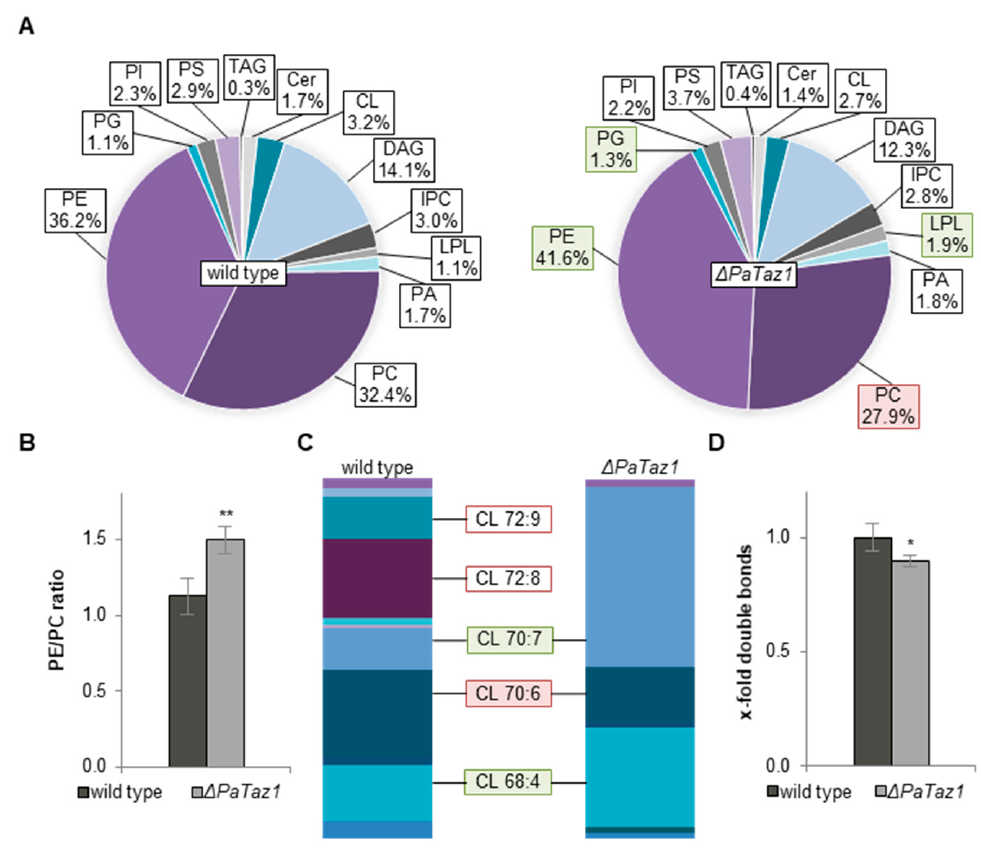
Figure 4. Loss of PaTAZ1 has a dramatic impact on phospholipid metabolism. ( A ) Lipid profiles of mitochondrial protein extracts of P. anserina wild type ( n = 5) and ∆ PaTaz1 ( n = 3). Significant differences to the wild type are marked with green (increase) or red (decrease) boxes, respectively. Exact values are shown in Supplementary Materials (Table S1). TAG: triacylglycerol; Cer: ceramide; CL: cardiolipin; DAG: diacylglycerol; IPC: inositol phosphorylceramide; LPL: lyso-phospholipids; PA: phosphatidic acid; PC: phosphatidylcholine; PE: phosphatidylethanolamine; PG: phosphatidylglycerol; PI: phosphatidylinositol; PS: phosphatidylserine. ( B ) PE/PC ratio of wild type and ∆ PaTaz1 . Data represent mean ± SD. ( C ) Graphical illustration of different CL species in wild type and ∆ PaTaz1 according to total length of all four acyl chains (66–72) and total degree of unsaturation (3–11). The most abundant CL species are represented (proportion > 10%). Significant differences to the wild type are marked by green (increase) or red (decrease) boxes, respectively. CL 72:8 and CL 72:9 are only represented in the wild type and are therefore marked with a red border. Exact values are shown in Supplementary Materials (Table S2). ( D ) Total double bonds across all lipids. Total amount of double bonds in wild type was set to 1. Data represent mean ± SD. Exact values are shown in Supplementary Materials (Table S3A). * p < 0.05, ** p < 0.01.